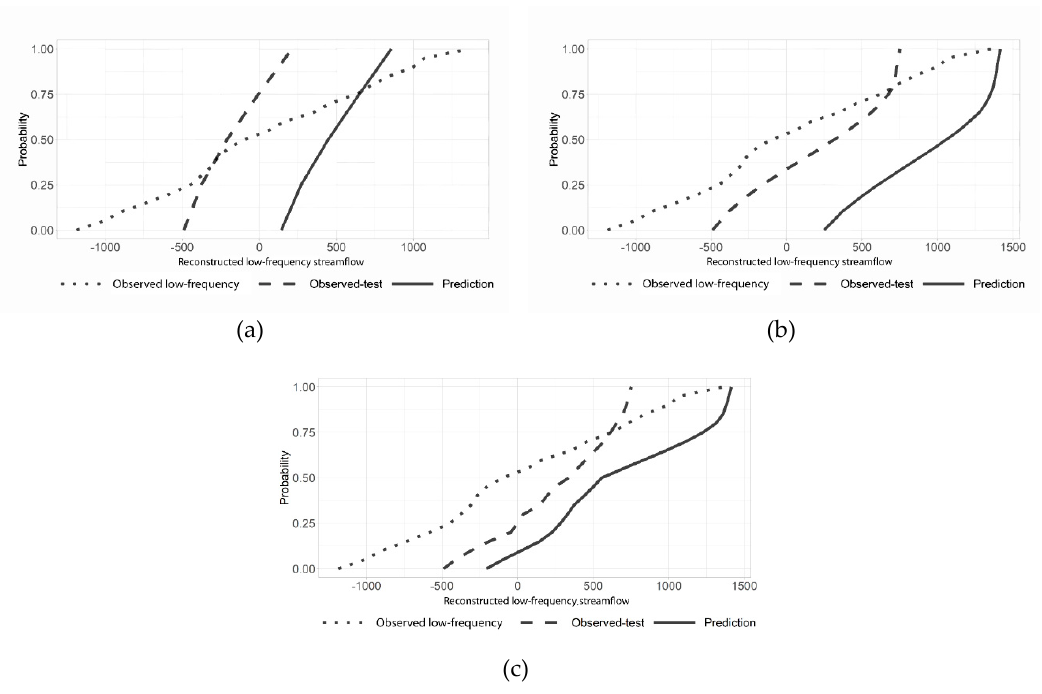
Figure 7. The CDFs of the predicted low-frequency streamflow, observed low-frequency streamflow for the test period, and the observed low-frequency streamflow from 1931 to 2016 in the ( a ) 5-year, ( b ) 10-year, and ( c ) 15-year projection.